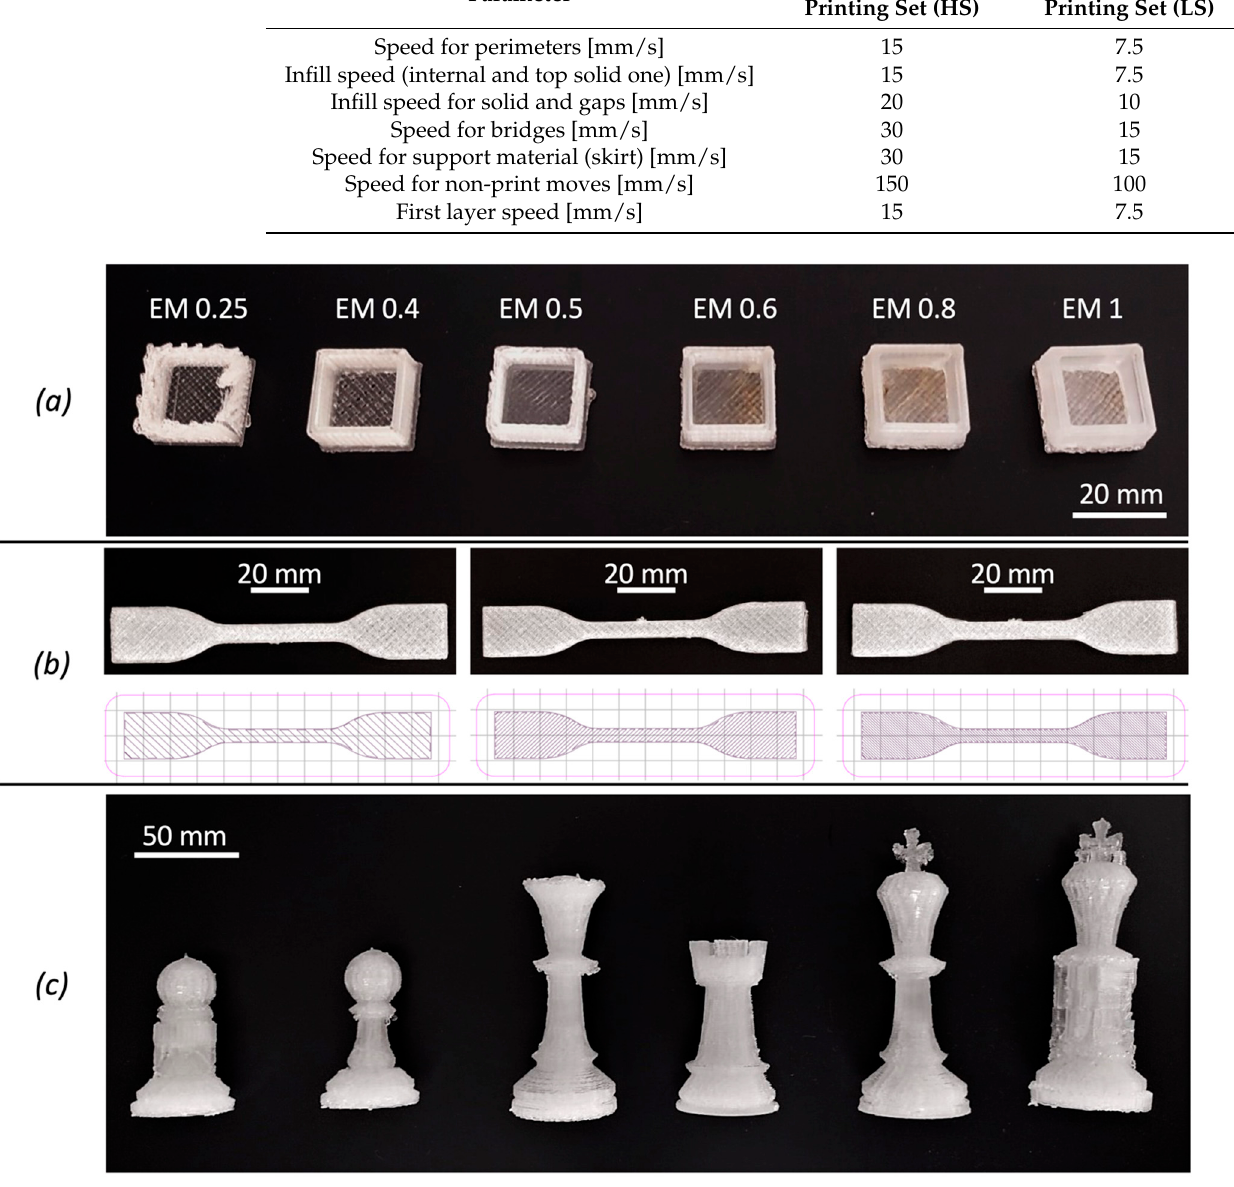
Figure 3. 3D printed samples by Fused Granular Fabrication: test cubes printed for different values of the extrusion multiplier ( a ); dumbbell specimens and print path for 25%, 50%, 75% infill ( b ) and all produced chess pieces ( c ).